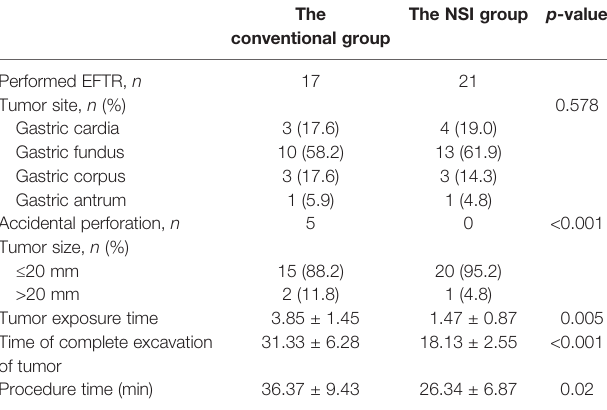
TABLE 3 | Characteristics of EFTR